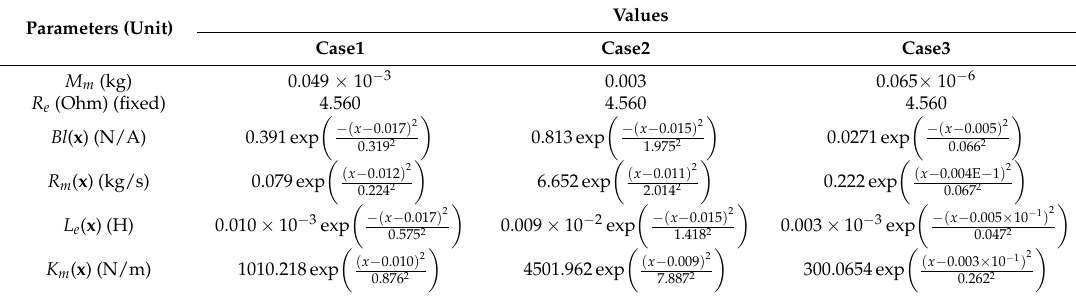
Table 2. Initial guesses of linear and nonlinear parameters.